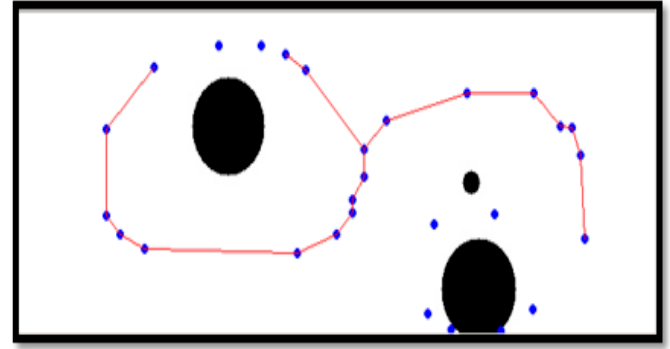
Figure 13. Modified driving path via searching path.